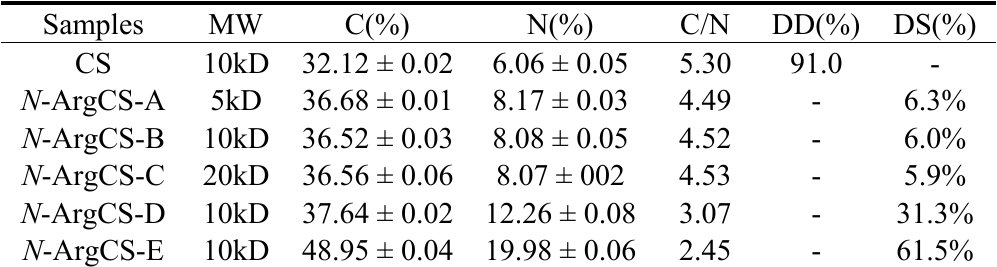
Table 1. The elemental analysis of CS and N- Arg-CS.